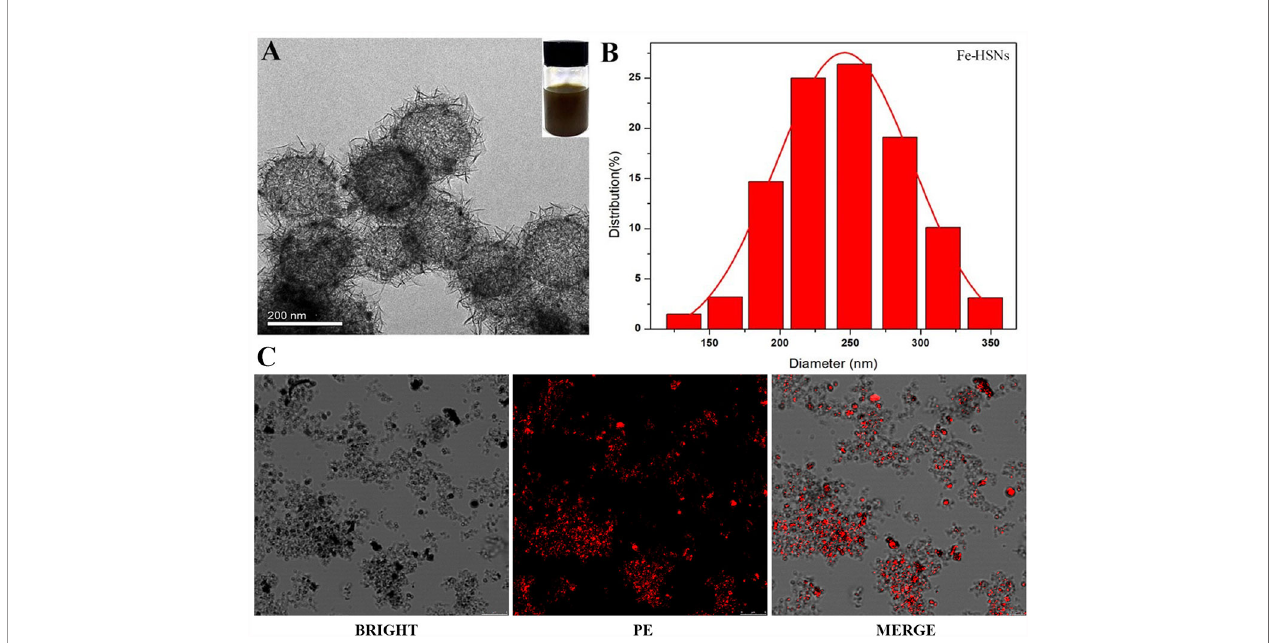
FIGURE 1 | Characteristic of NPs. (A, B) TEM and diameter distribution image of Fe-HSNs. (C) LSCM images of VEGFR2-PEG-HSNs-Fe. VEGFR2-PEG-HSNs-Fe modi fi ed with luciferin PE by laser excitation showed red fl